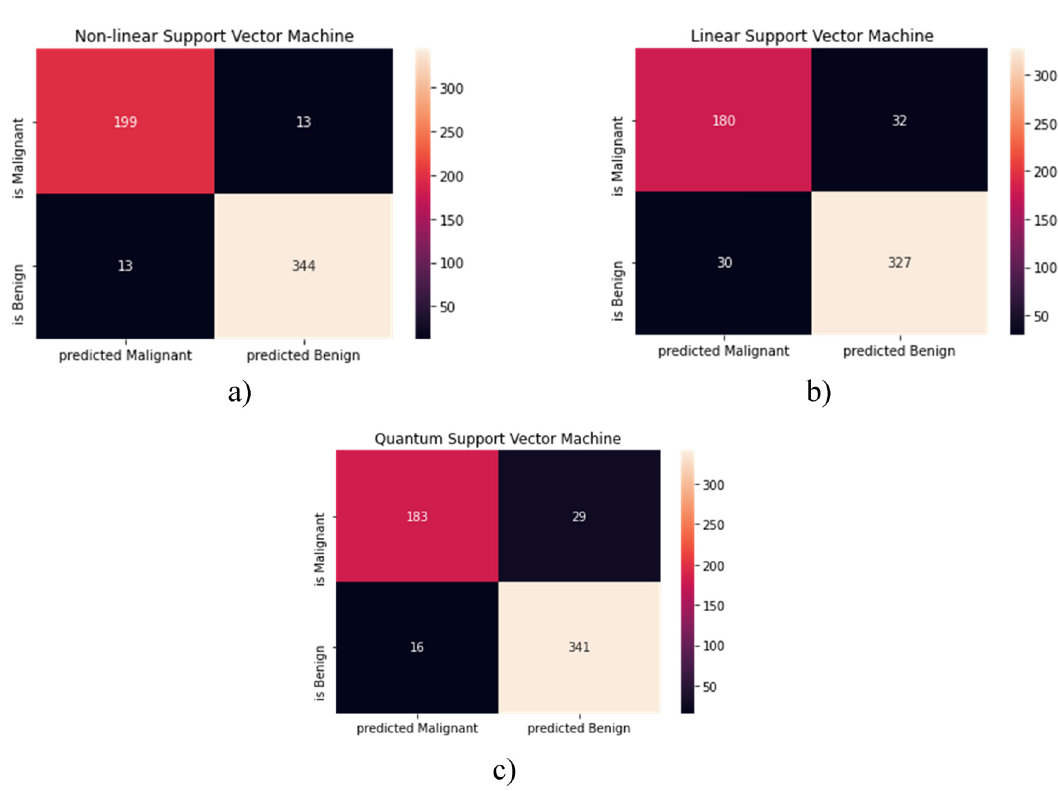
Figure 6: Confusion matrix for ( a ) linear SVM model, ( b ) nonlinear SVM model, and ( c ) quantum SVM